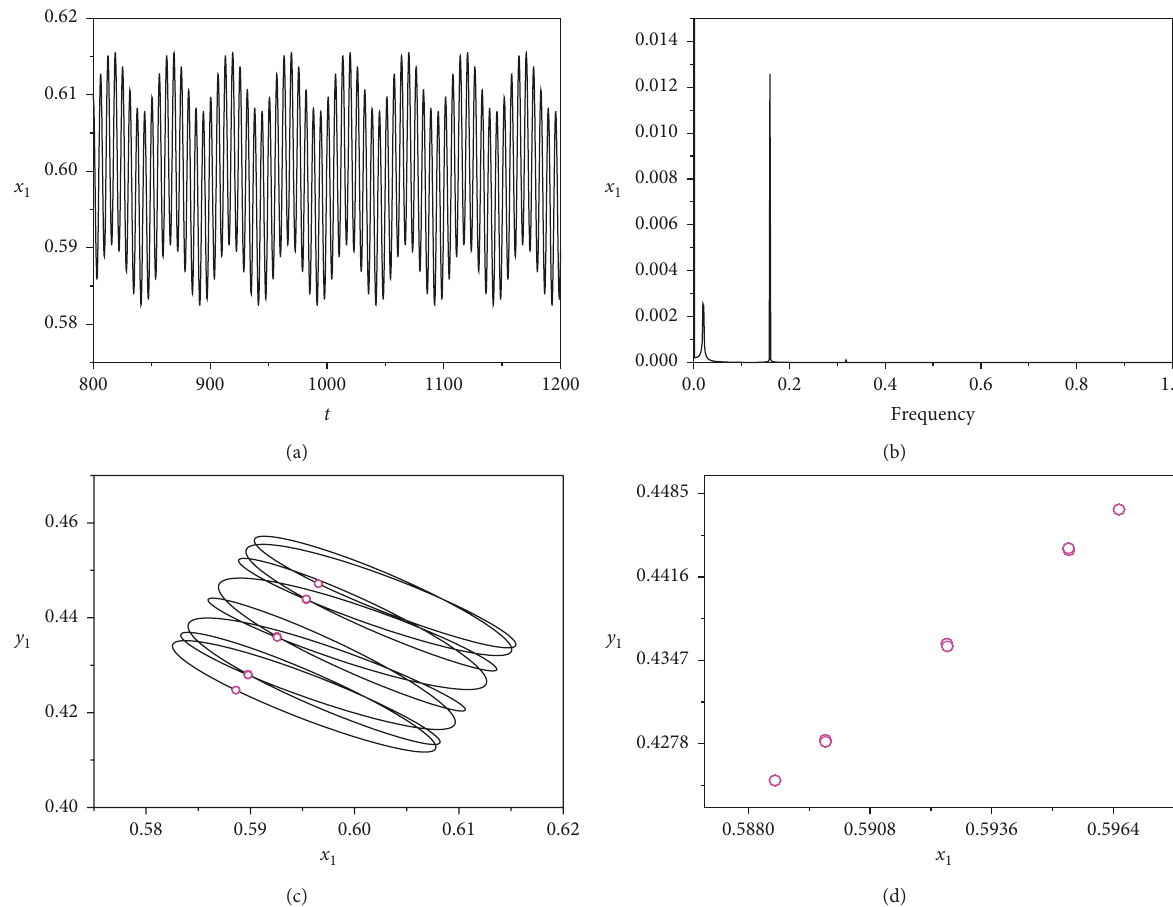
Figure 22: ω � 2.20 and ϕ � 0.100: (a) displacement response; (b) frequency spectrum; (c) rotor orbit; (d) Poincar´e